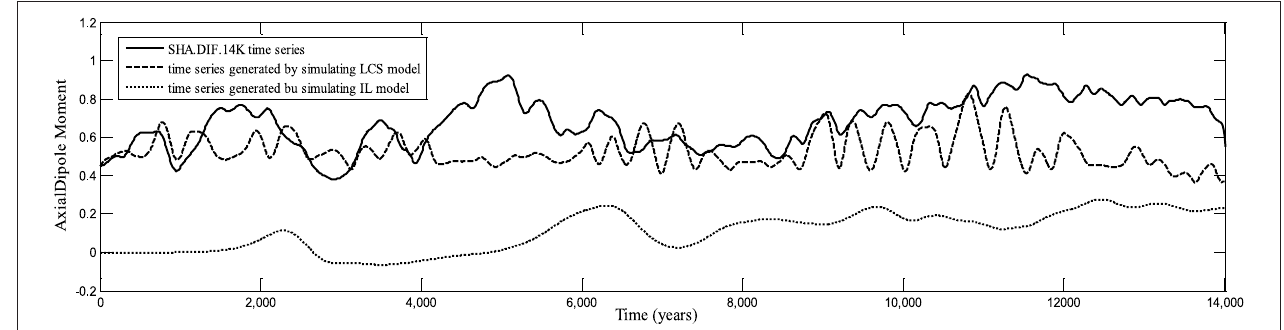
FIGURE 8 | Short time series generated by LCS and IL models compared with the SHA.DIF.14K model time series.